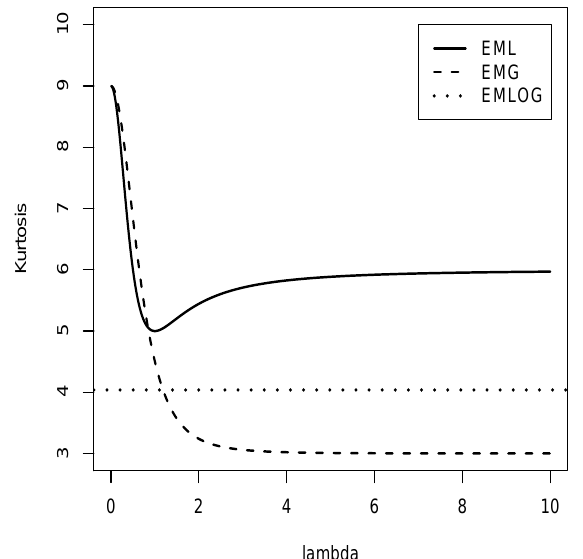
Figure 4. Graphical comparison of the kurtosis coefficient between the exponentially modified Laplace distribution (solid line), the exponentially modified Gaussian distribution (dashed line), and the exponentially modified logistic distribution (dotted